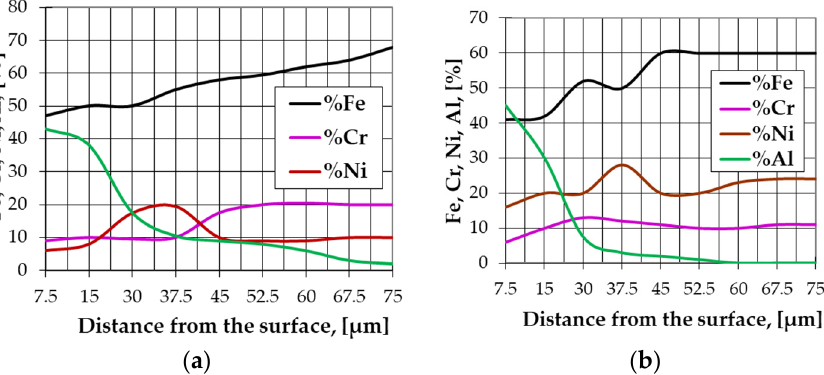
Figure 1. Distribution of Al and alloying elements in the alited layer for an austenitic stainless steel—type 18/8, stabilized with Ti ( a ), and of high refractory alloy steel—0.1% C; 23% Ni; 11% Cr; 3% Ti; 1.3% Mo ( b ).